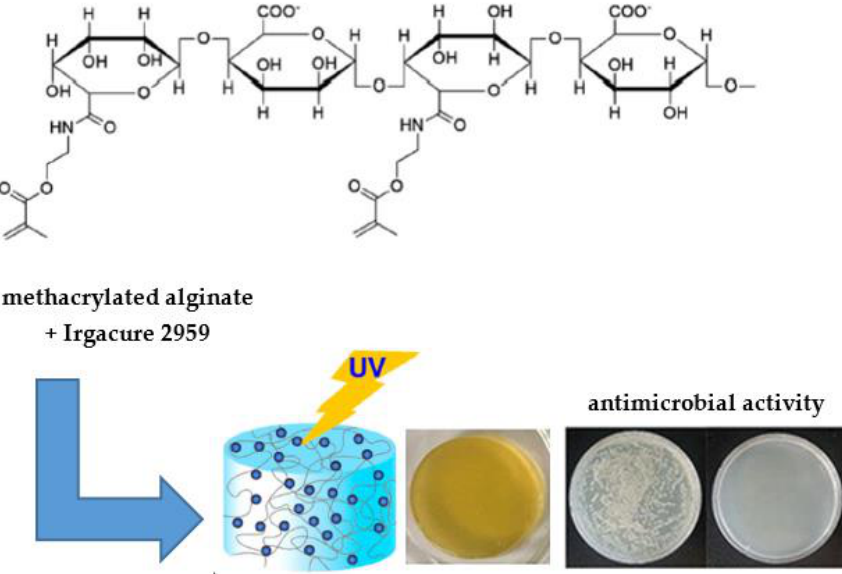
Figure 13. Illustration of the preparation of a methacrylated-alginate-based hydrogel using free- radical photopolymerization in a silver nanoparticle aqueous solution and its antibacterial activity (left: hydrogel without silver NPs; right: hydrogel obtained using a 1.5 nM silver NP aqueous solution). Reprinted with permission. Copyright 2020, Taylor and Francis Online [43].